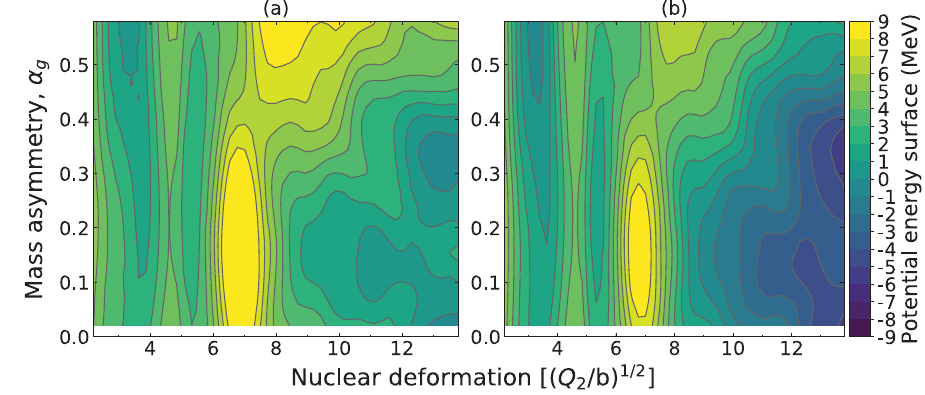
Figure 2. The calculated nuclear potential energy surfaces of (a) 236 U and (b) 240 Pu using the MicMac code recently developed at Los Alamos. The high-dimensional surfaces are projected down onto mass asymmetry and nuclear deformation. The yellow ridge seen at moderate elongations suggests both systems should fission